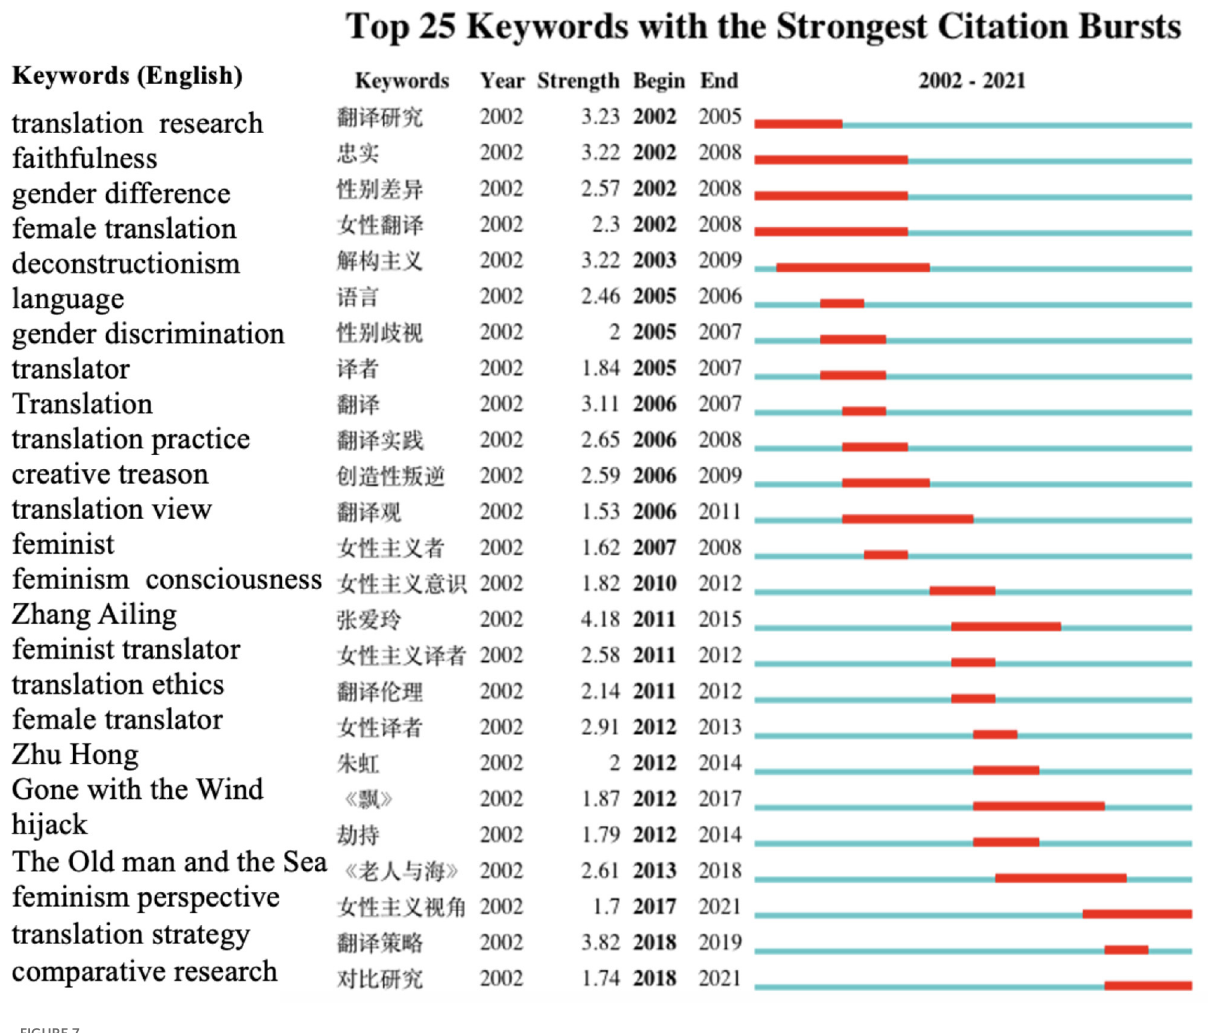
FIGURE7 Keywords mutation